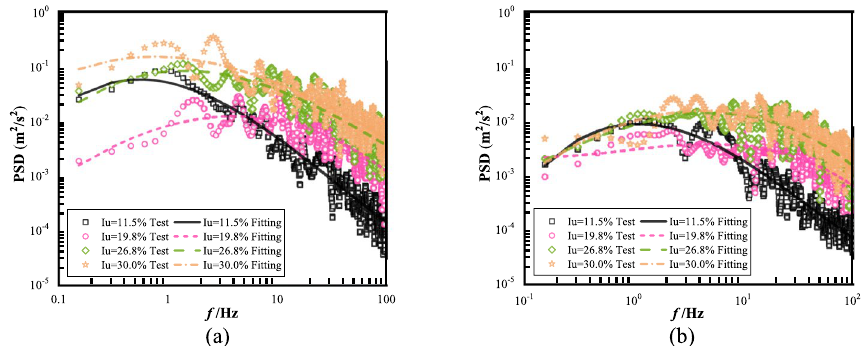
Fig. 2 Wind spectrum functions features of four kinds of turbulence flow fields (Incoming wind velocity is